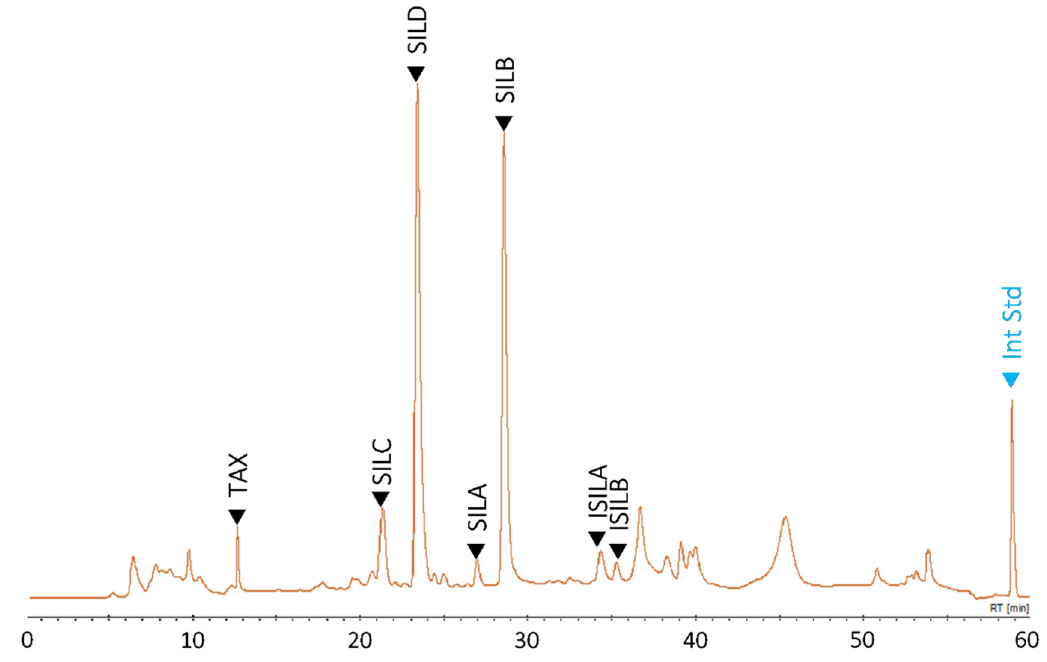
Figure 3. Representative HPLC chromatogram of an extract prepared by UAE of a mature fruits (achenes) of a milk thistle ( S. marianum ) commercial cultivar. The main compounds considered in this study are the flavonoid taxifolin (TAX) and the flavonolignans: silychristin (SILC), silydianin (SILD), silybin A (SILA), silybin B (SILB), isosilybin A (ISILA) and isosilybin B (ISILB). Int Std: internal standard (6-methoxyflavone). Table 2. Results of full factorial design experiments for the extraction of silymarin (SILM) from mature fruits of S. marianum .